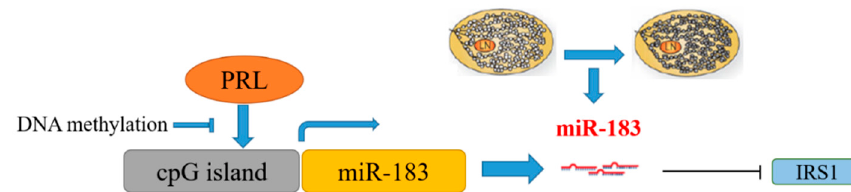
Figure 10. Mechanism of the PRL / miR-183 / IRS1 pathway regulating milk fat metabolism in CMECs. Supplementary Materials: The following are available online at http: // www.mdpi.com / 2073-4425 / 11 / 2 / 196 / s1. Table S1: The sequences used for miR-183. Table S2: The PCR products sequencing data of nine reference genes. Table S3: The sequences used for IRS1-siRNA. Table S4: The sequences used for construction target gene 3 (cid:48) -UTR luciferase reporter